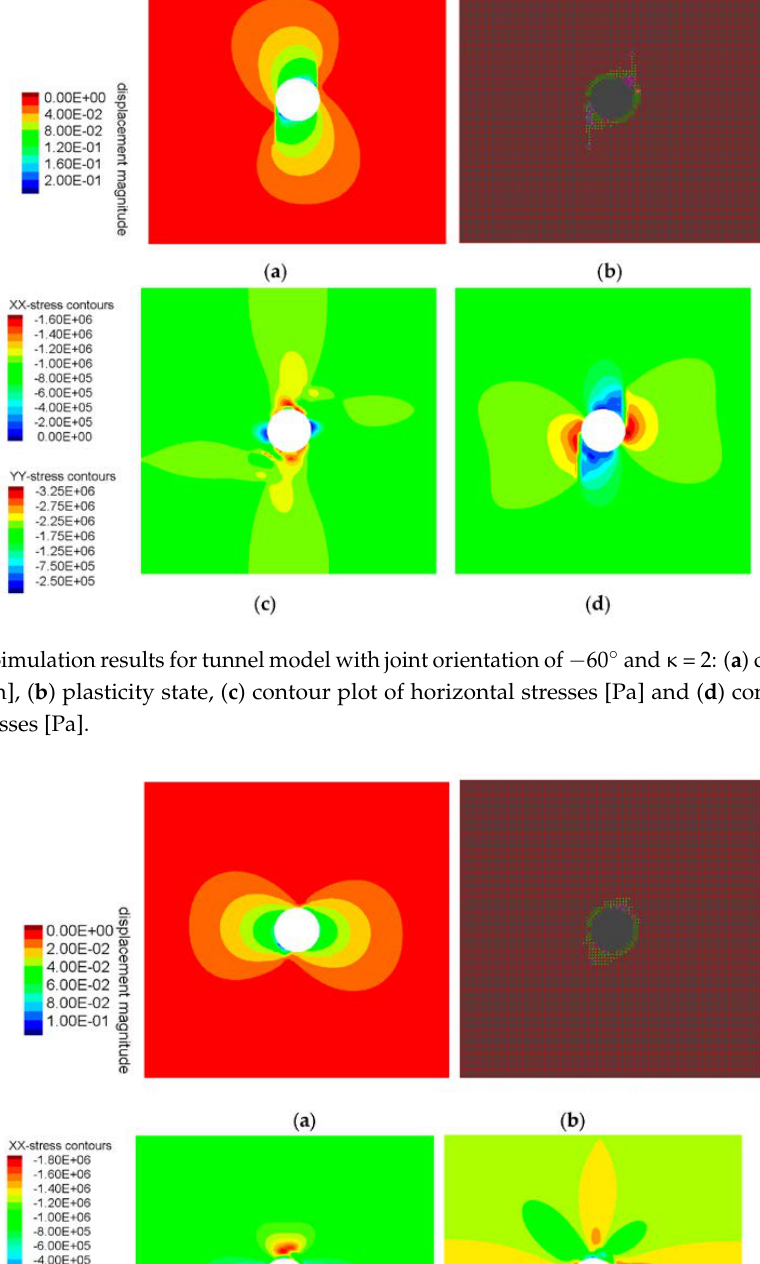
contours [m], ( b ) plasticity state, ( c ) contour plot of horizontal stresses [Pa] and ( d ) contour plot of vertical stresses [Pa].